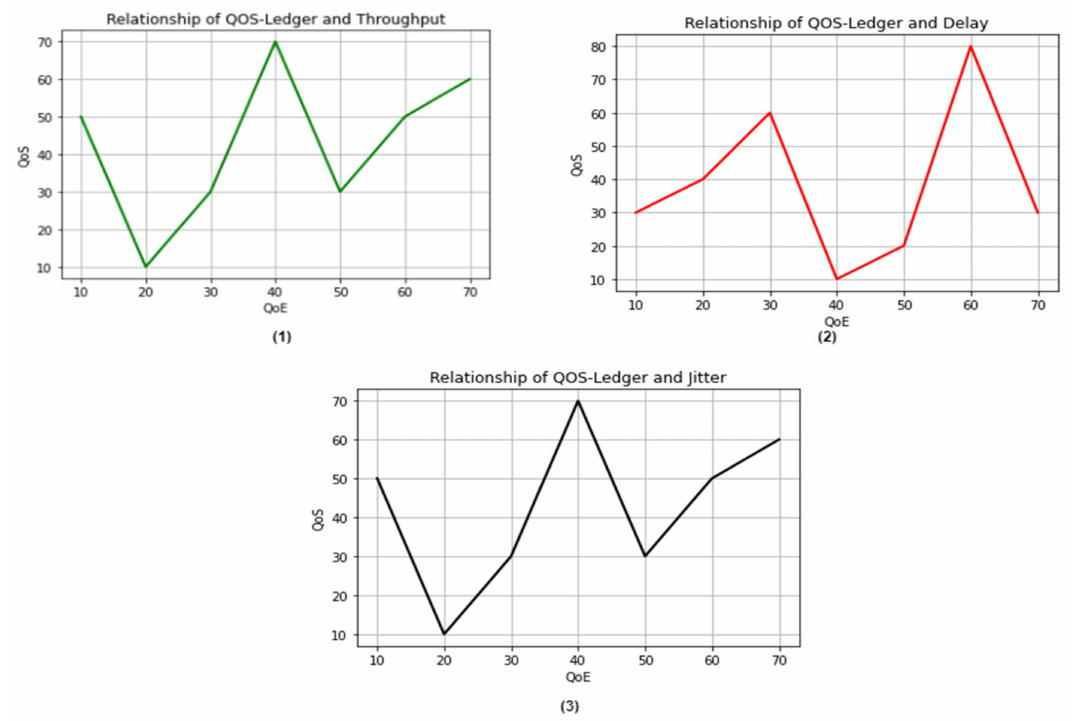
Figure 6. QoS-ledger’s relationship with defined QoS indicator matrices: ( 1 ) QoS and throughput; ( 2 ) QoS and delay; and ( 3 ) QoS and